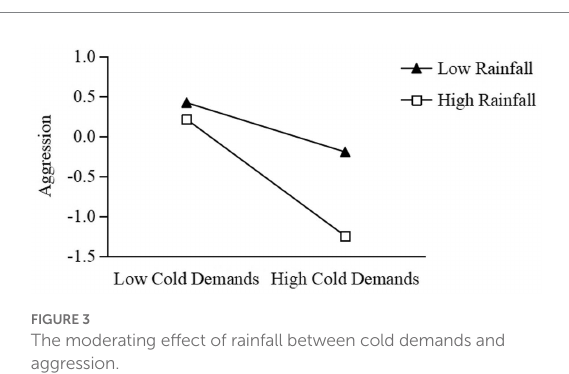
FIGURE 3 The moderating effect of rainfall between cold demands and